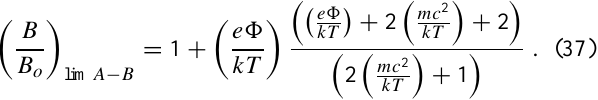
(cid:0) (cid:14) (cid:1) = e8 kT 20